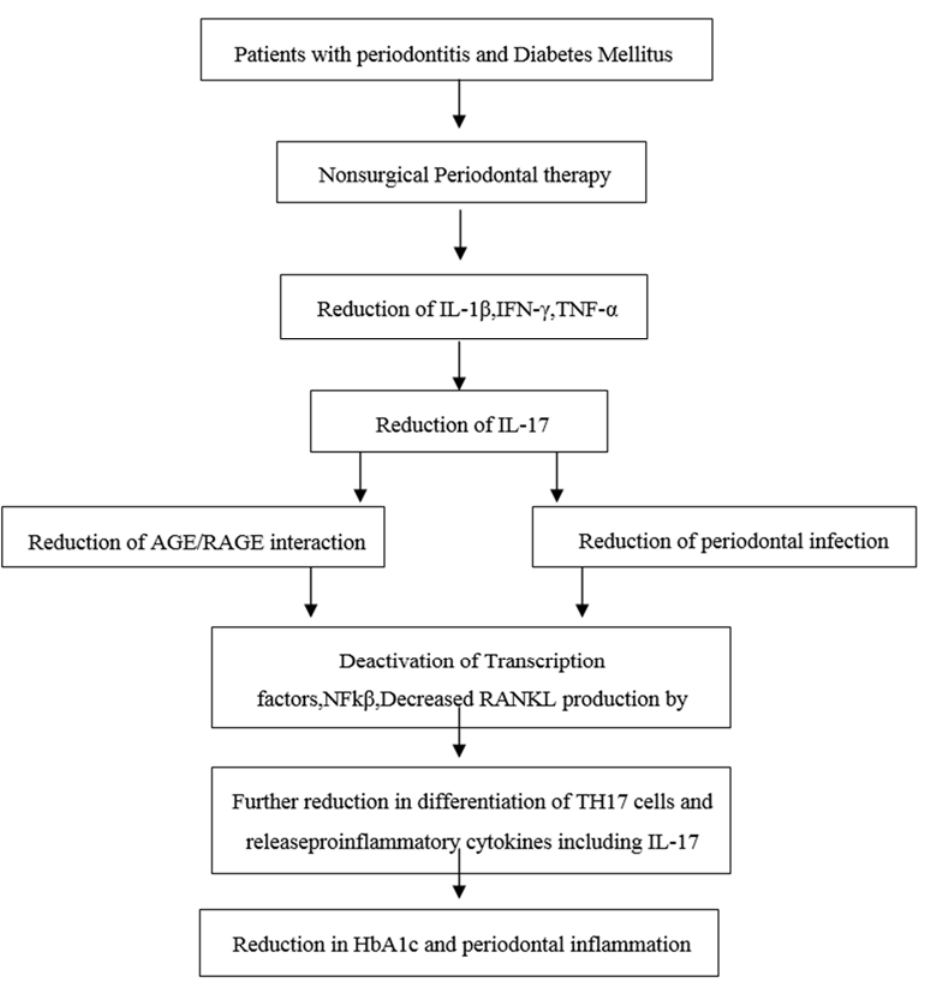
Figure 2. Possible role of Nonsurgical periodontal therapy in the prevention of periodontal tissue destruction and diabetes mellitus by down-regulating IL-17 levels.